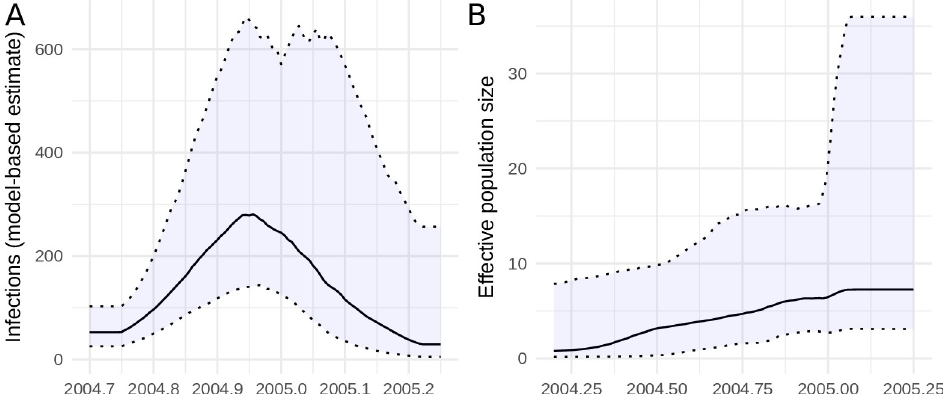
Fig 2. The estimated effective number of H3N2 human influenza infections in 2004-2005 in New York State. A. Estimates obtained using the parametric seasonal influenza model described in the text. B. Effective population size estimated using a conventional Bayesian skyline